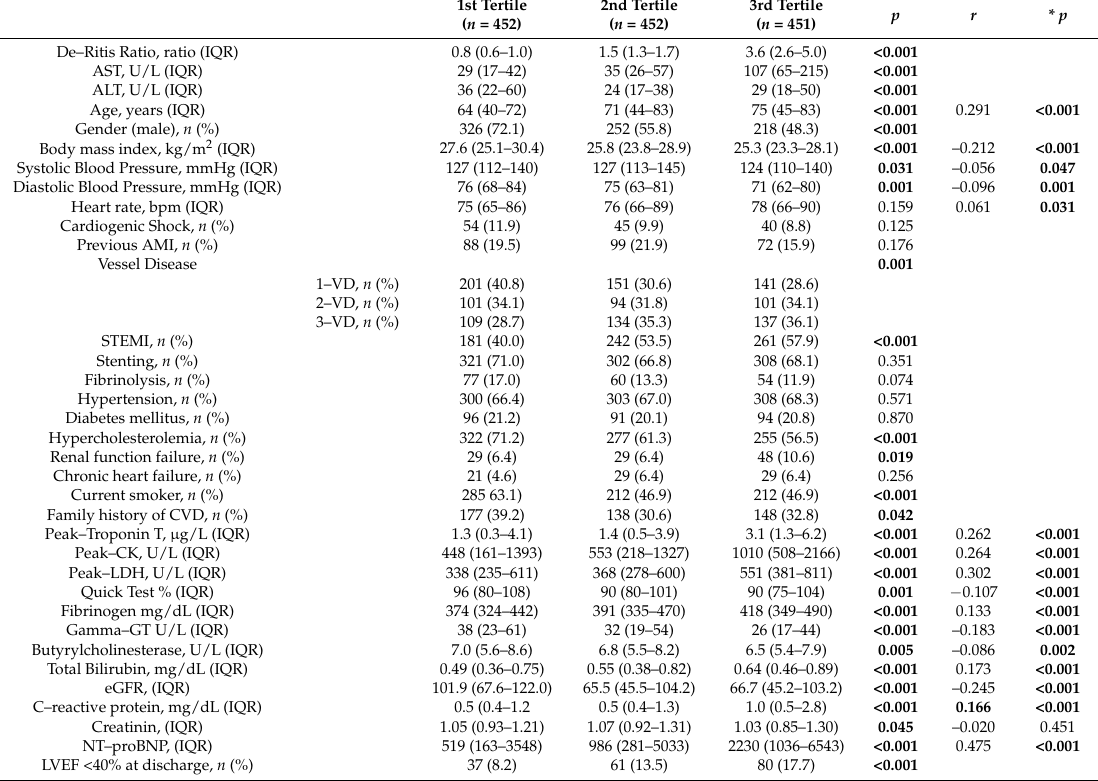
Table 1. Baseline characteristics.